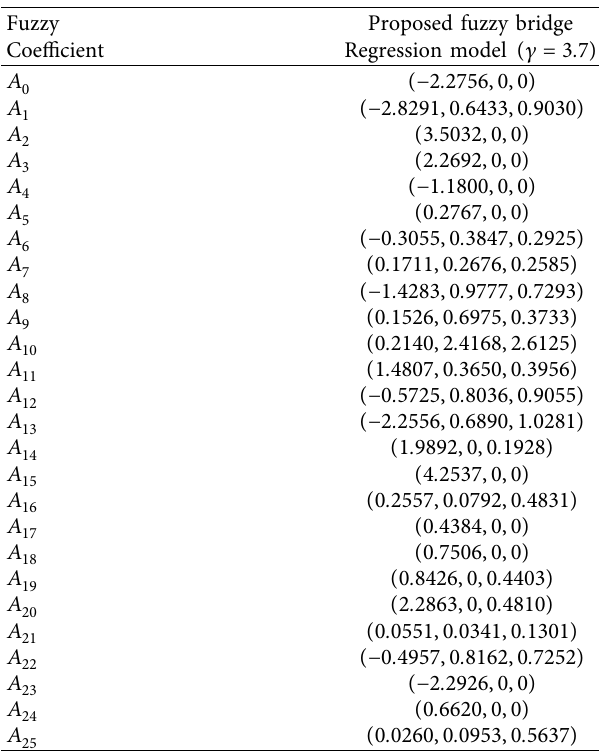
Table 3: Coefficients of fuzzy bridge regression models with c � 3 . 7, corresponding to the 15 th simulated dataset in Example 1. Fuzzy Proposed fuzzy bridge Coefficient Regression model ( c � 3 . 7